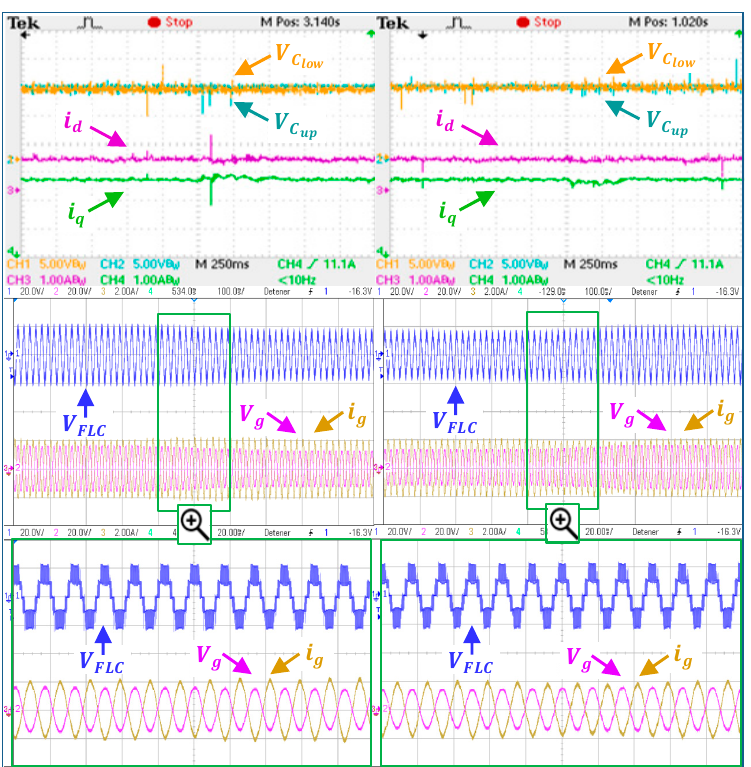
Figure 14. Performance of the voltage balancing strategy and the vector control for the proposed grid-tied SPFLC during a grid voltage sag/swell.